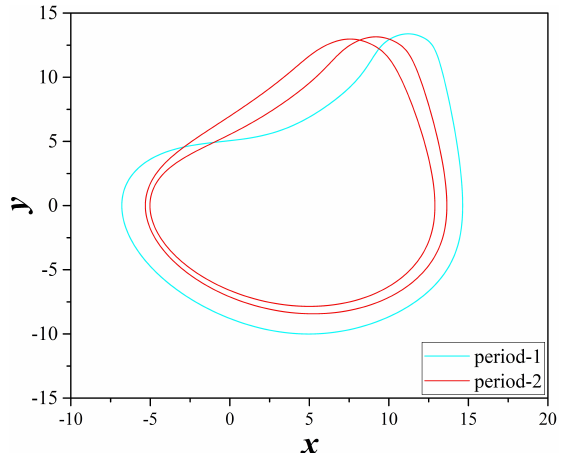
Figure 16. Coexisting attractors of system (2), for a = 4 × 10 − 4 , b = 1, c = 3.846 × 10 − 4 , d = 1 and e = 1.15. With cyan color and for ( x 0 , y 0 , z 0 ) = ( 0,0.1,0 ) a period-1 attractor, while with red color and ( x 0 , y 0 , z 0 ) = ( − 5.3168311,0,4.9638148 ) a period-2 attractor.